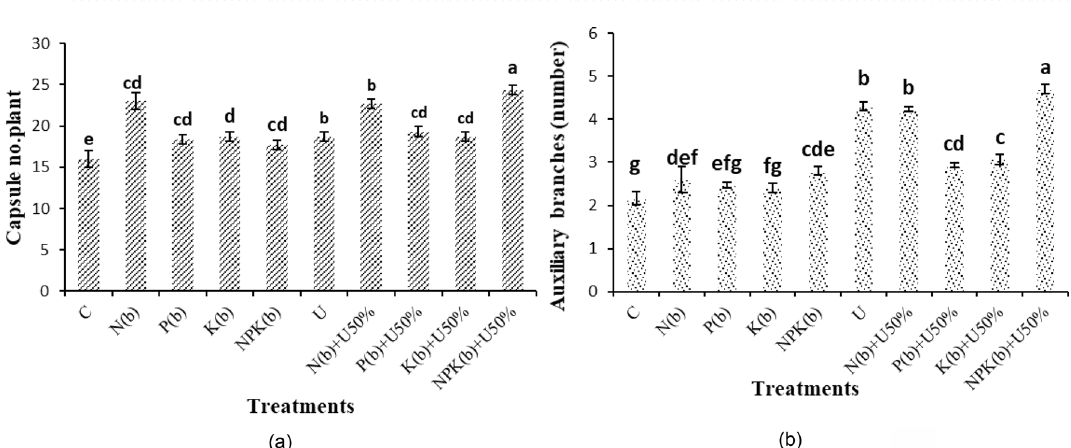
Figure 2. Means comparison for capsule number per plant and number of auxiliary branches of Nigella sativa L. as influenced by biofertilizers and urea. Dissimilar letters show significant differences at the p ≤ 0.01 level. Control (C), U Chemical urea, Nb (biological N), Pb (biological P), Kb (biological K, NPKb (mixed biological NPK), Nb + U50%, Pb + U50%, Kb + U50%, and NPKb +